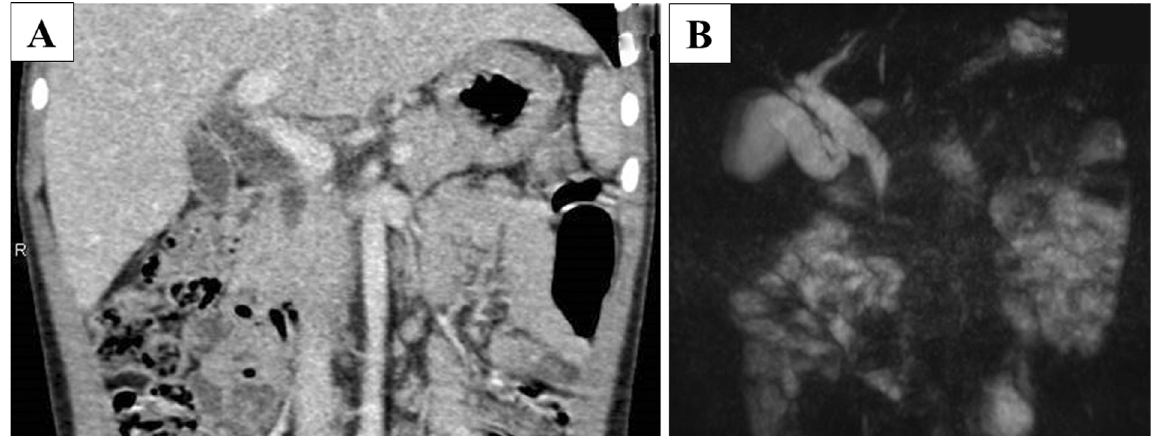
Fig. 1 Computed tomography ( A ) and magnetic resonance cholangiopancreatography ( B ) show a 17-mm type Ia choledochal cyst according to the Todani classi fi